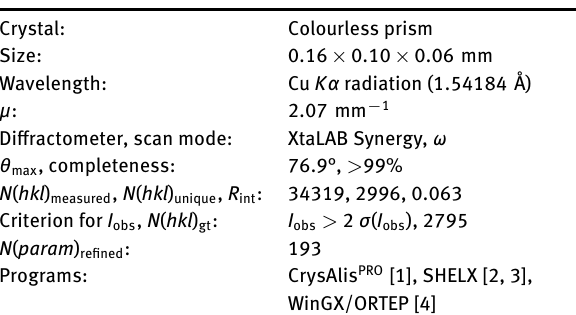
Table 1: Data collection and